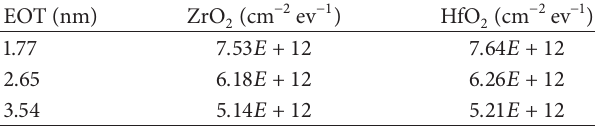
value for ZrO it